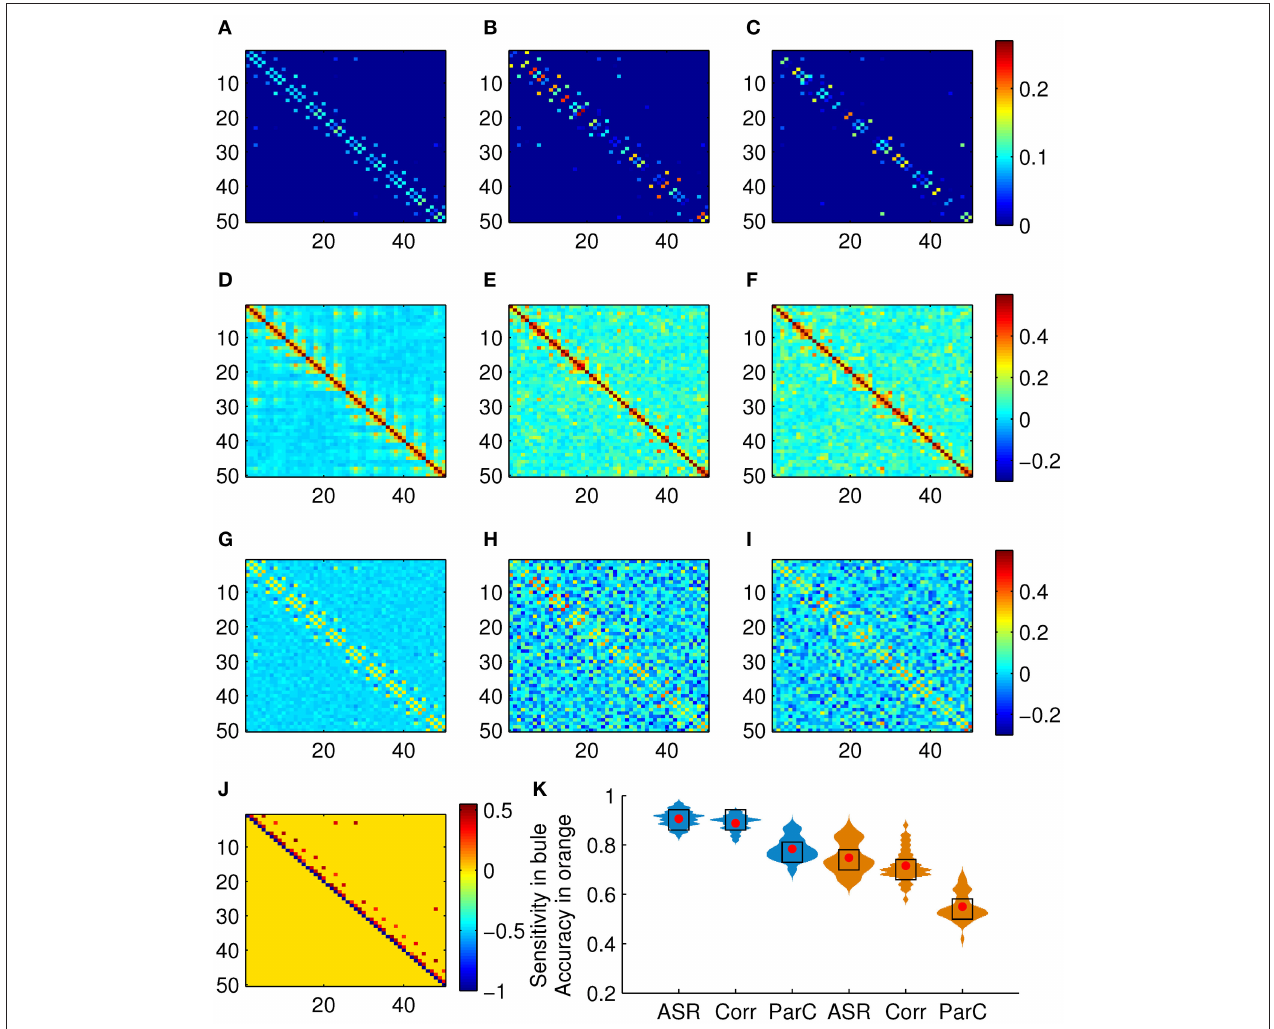
FIGURE 3 | Results on the simulated data set. (A) Mean association matrix averaged over 50 subjects by using ASR. Panels (B,C) are association matrices derived from ASR on two randomly selected subjects. (D) Mean association matrix averaged over 50 subjects by using the Pearson correlation. Panels (E,F) are the corresponding association matrices derived from the Pearson correlation on the two randomly selected subjects. (G) Mean association matrix averaged over 50 subjects by using the partial correlation. Panels (H,I) are the corresponding association matrices derived from the partial correlation on the two randomly selected subjects. (J) Ground truth of connection matrix. (K) Sensitivity (drawn in blue) and clustering accuracy (drawn in orange) distributions (with width denoting frequency) of ASR, the Pearson correlation, and the partial correlation over 50 subjects, where red dots and black blocks represent the mean and the median